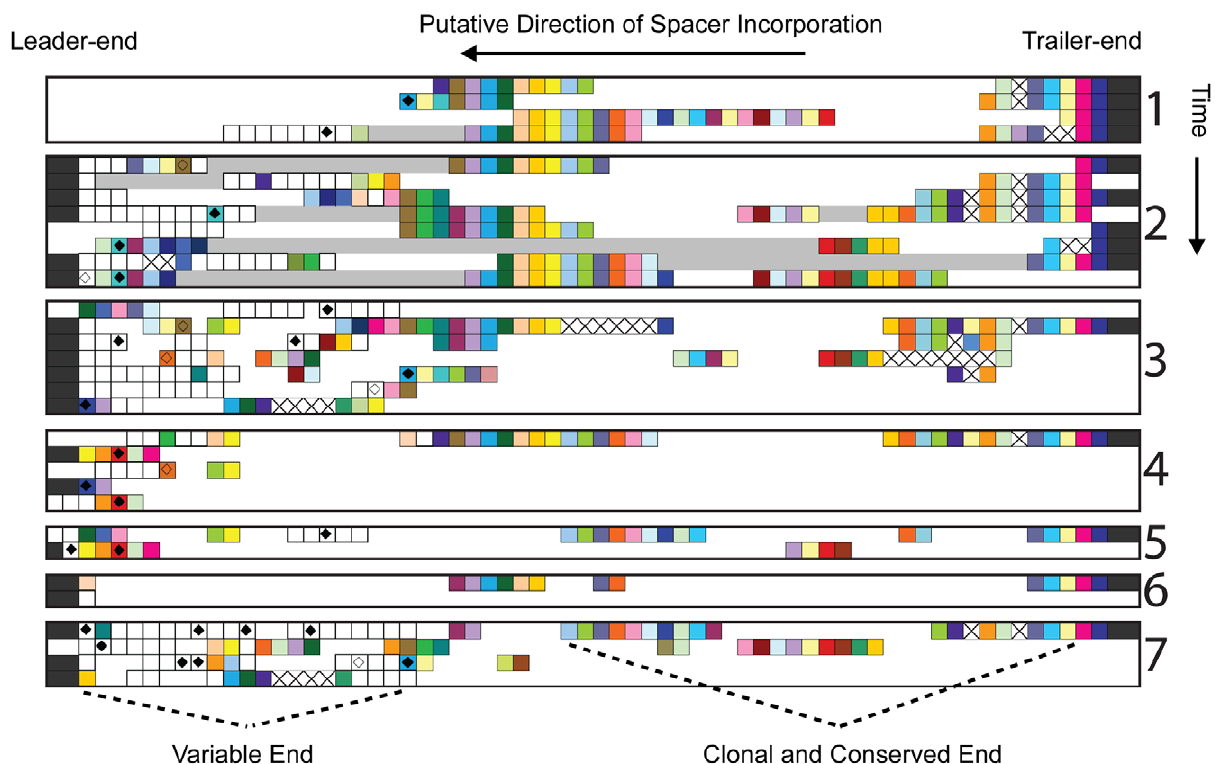
Figure 1. Trailer-end conservation and clonality documented in G-plasma CRISPR loci # 1. Metagenomic reconstructions of the first CRISPR locus of a G-plasma population sampled in 2002 (1), 2005 (2), June 2006 (3), August 2006 (4) November 2006 (5), May 2007 (6) and August 2007 (7). In each sampling, the CRISPR spacers (boxes) are aligned horizontally according to their ordering in the metagenomic reads, with CRISPR repeats removed for compactness. Overlapping 454 spacer patterns are also condensed (Methods). The left-ends are the leader-ends, where new spacers are unidirectionally incorporated. Boxes filled with the same color represent identical spacers, with two exceptions. Black-filled boxes show flanking genetic material and white-filled boxes denote cell-specific spacers found only once in the dataset. White gaps reflect unsequenced regions in the metagenomic reconstructions. When separated spacers can be linked via paired reads, the intervening region is shown as a grey bar. Boxes containing a black ‘X’ indicate probable spacer deletions. When spacers match reconstructed AMDV3b viral sequences, diamonds are inserted, with filled diamonds showing perfect matches and open diamonds reflecting imperfect matches. Trailer-end conservation (presumed immunological memory) and clonality are pronounced in this locus, with large numbers of matching spacers preserved across the six-year period. Another example of trailer-end conservation and clonality—in the CRISPR loci of archaeal I-plasma—is shown in Figure S1.